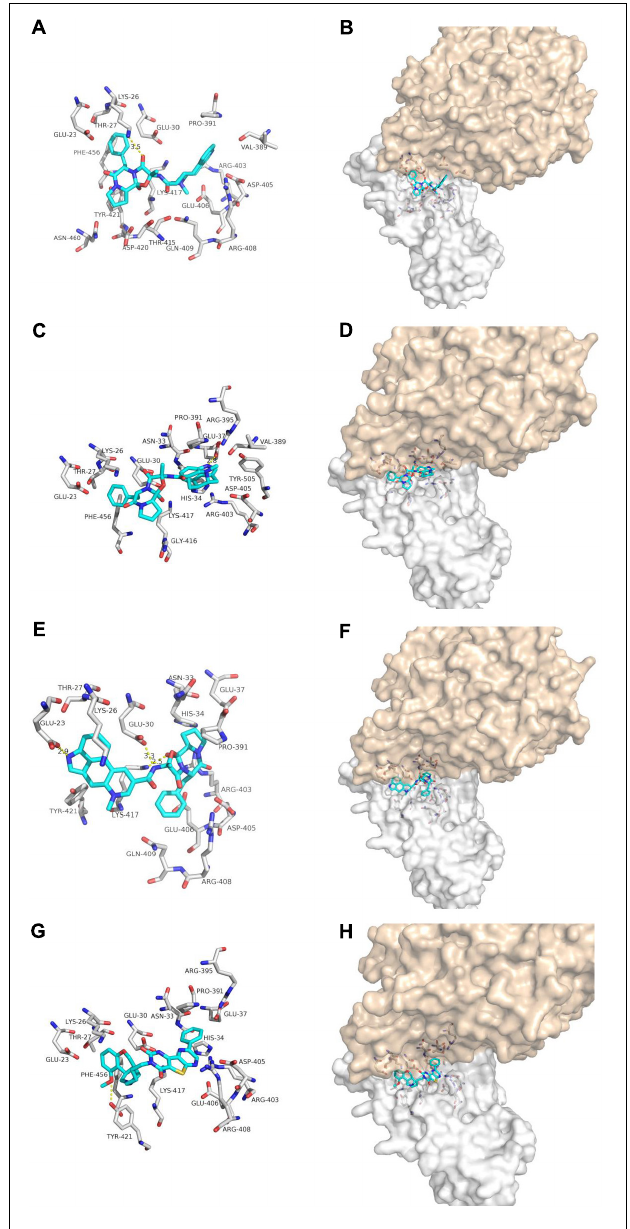
FIGURE 4 | The binding model of non-antiviral drugs with the interface of ACE2 and Spike glycoprotein complexes. Antiviral drug binding model with ACE2 and Spike glycoprotein complexes interface. (A,C,E,G) are the binding models of ACE2 and Spike glycoprotein complexes with antiviral drugs, Olysio (cyan) and related residues (off-white), (B,D,F,H) are compound Olysio (blue). The interaction-green model is located at the interface of the Spike glycoprotein complex (between coffee and white surface). The yellow dotted line indicates the interaction distance (A). (A,C,E,G) or (B,D,F,H) are dihydroergotamine, dihydroergotoxine, ergotamine, fiduxosin, respectively.